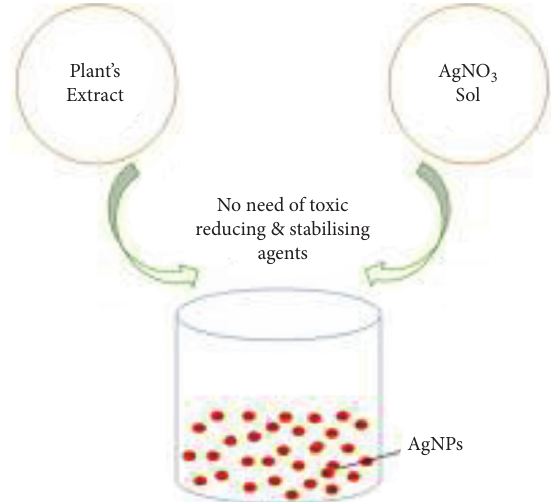
Figure 5: Green synthesis of AgNPs [29].